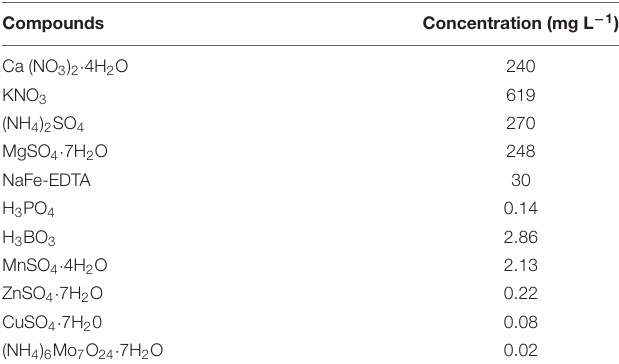
TABLE 1 | Composition of the nutrient solution for